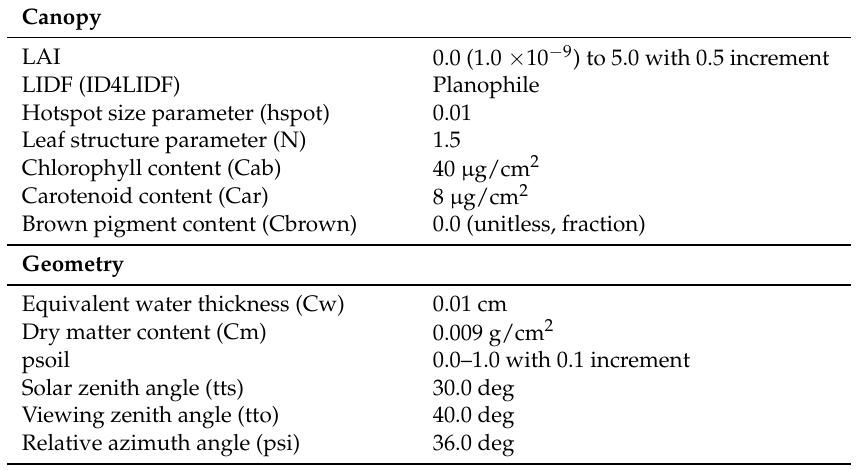
Figure 10. SRFs for the AHI and MODIS, and spectral reflectances of the vegetation canopy simulated using PROSAIL. The values of LAI and psoil were assumed to be 2.5 and 0.0, respectively. Circles indicate the spectrally convoluted reflectances using SRFs. In the green bands, reflectance differences between AHI and MODIS were greater than in the other bands. Table 9. Input parameters for the PROSAIL algorithm used in the numerical simulations. The LIDF is the leaf inclination distribution function. The parameter psoil was used to describe the moisture-induced reflectance changes in the soil surface (from wet to